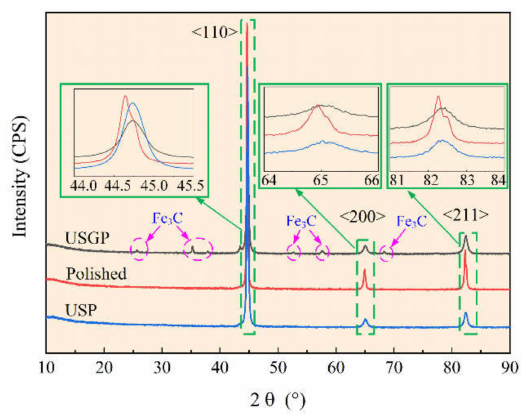
Figure 11. The X-ray diffraction pattern characteristics of the samples’